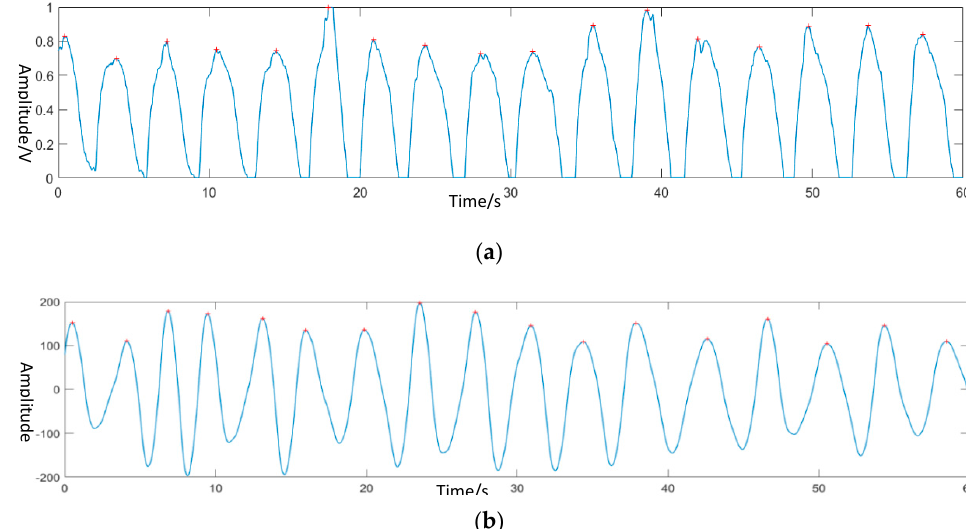
Figure 6. Respiratory signal. ( a ) The original signal from the contact band sensor; ( b ) Reconstructed respiratory signal.